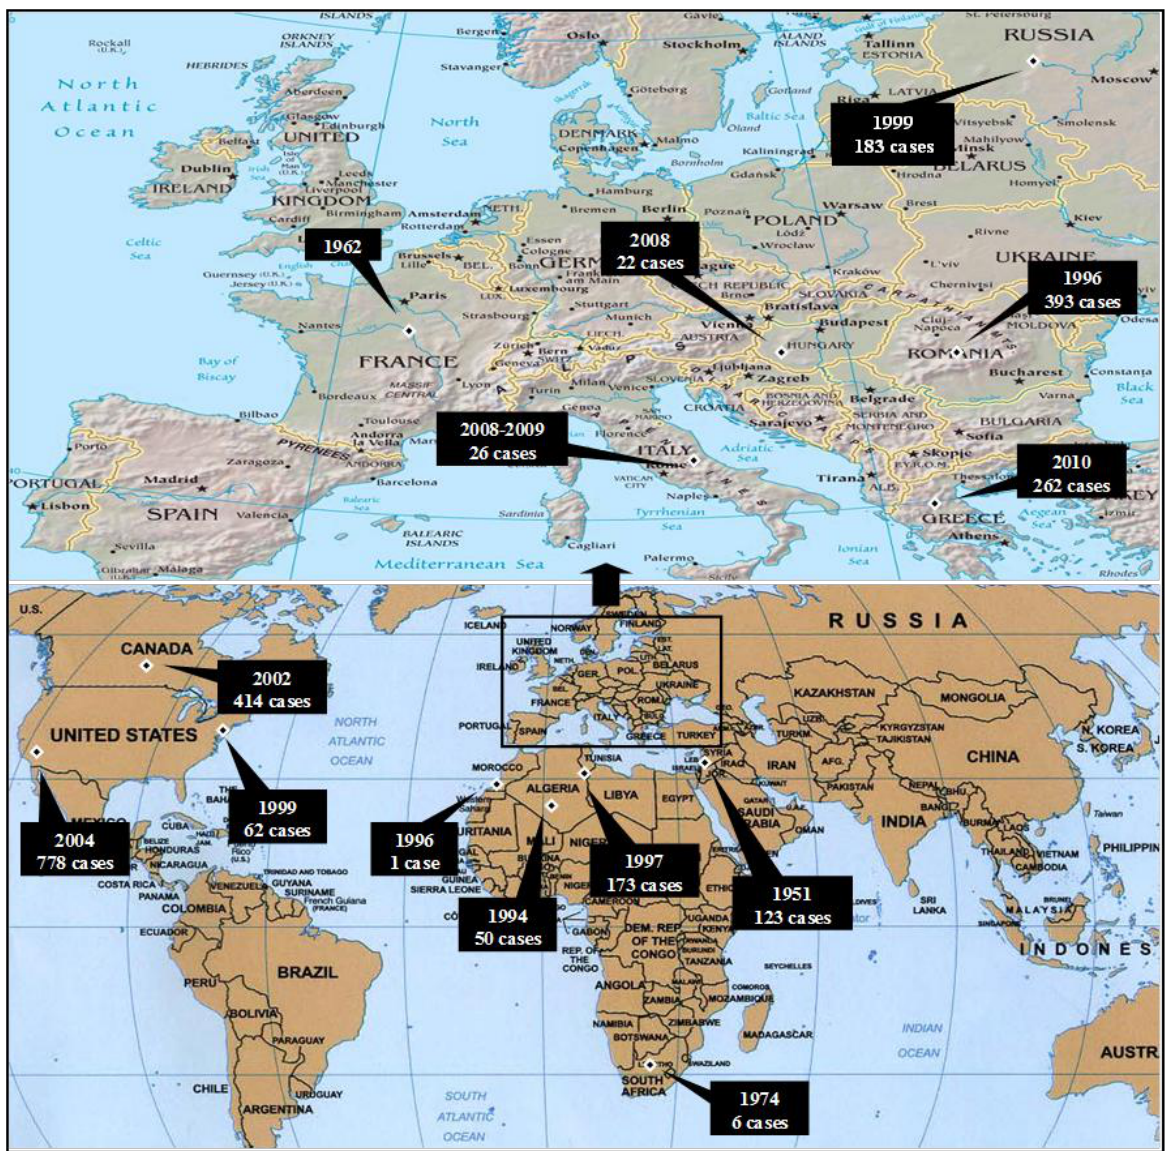
Figure 2. The most significant WNV human outbreaks worldwide,